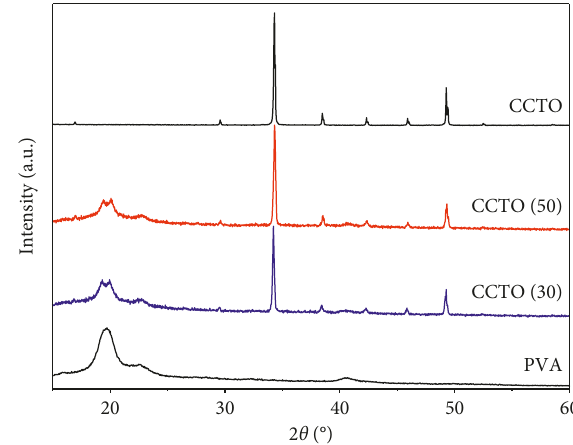
Figure 1: Transmission of the cavity with and without PTFE samples, showing the two resonances separated by ∆ f .